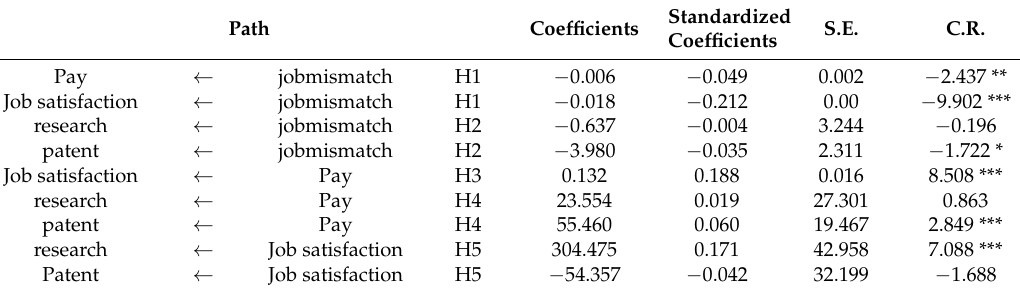
Table 5. The Structure Evaluation Model analysis.